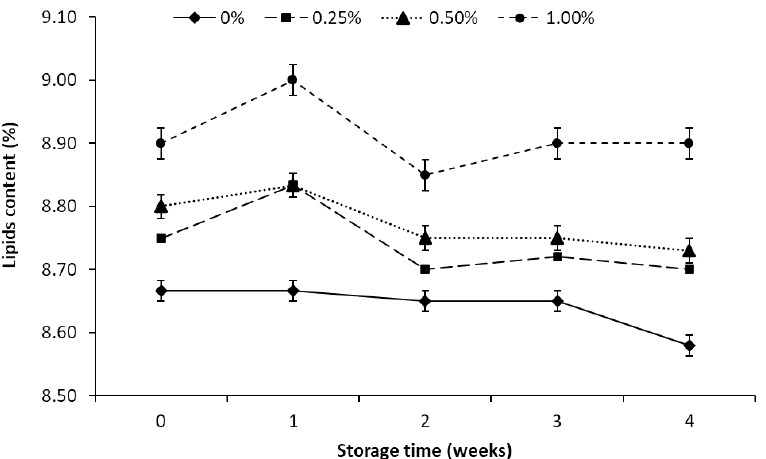
Figure 1. Lipids content in acid curd cheese with different addition (0–1%) of astaxanthin lipid preparation (ALP) during 4 weeks of refrigerated storage (5 ± 1 °C).